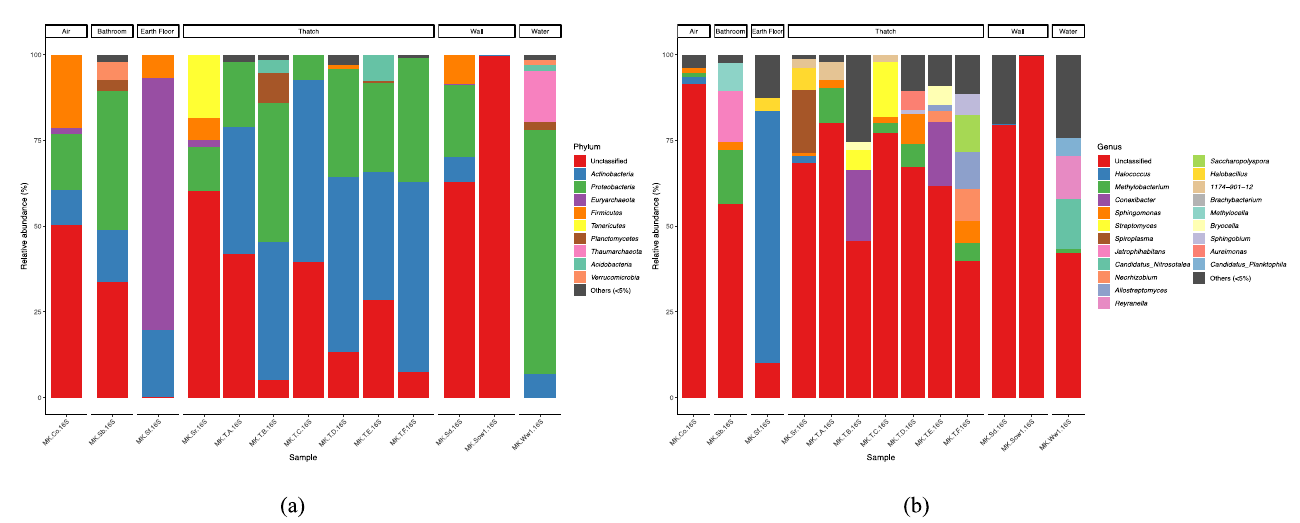
Figure 12. Taxonomic composition of prokaryotes at the phylum ( a ) and genus ( b ) levels.